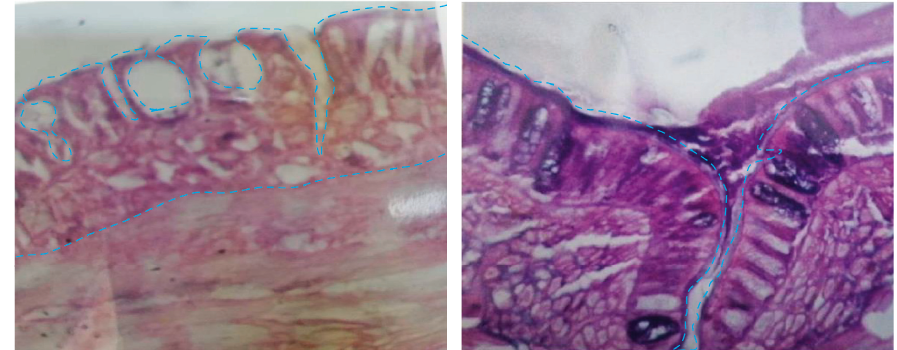
Figure 4: A longitudinal section of the body wall of the group of worms exposed to a concentration of 50ppm shows cuticle and cuticle rupture, as well as cell shrinkage, laceration, and disappearance of their features. Pigment (H and E) magnification